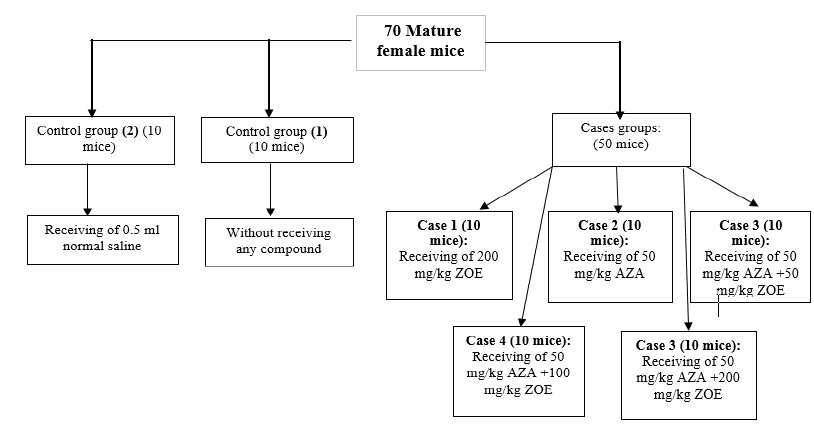
Fig. 2. Animal grouping procedure in the present study [ AZA: Azathioprine; ZOE: Zingiber officinale L.